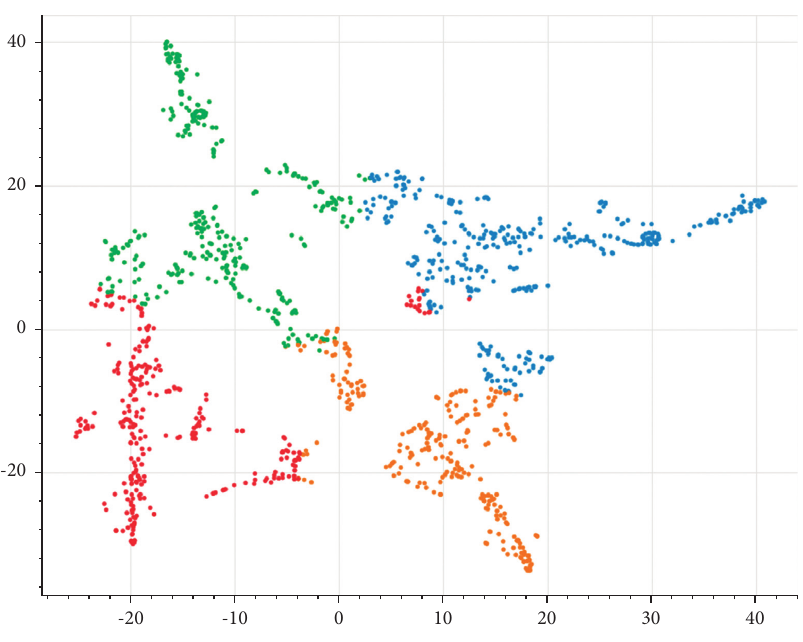
Figure 6: t-SNE cluster